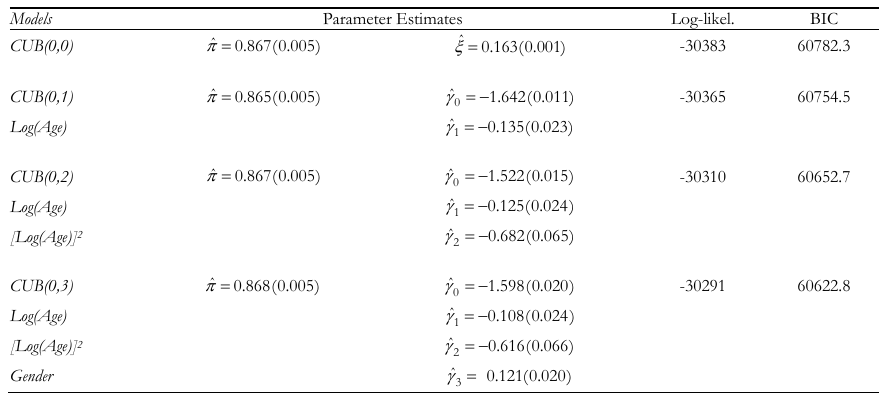
CUB models for subjective survival probabilities to age 75